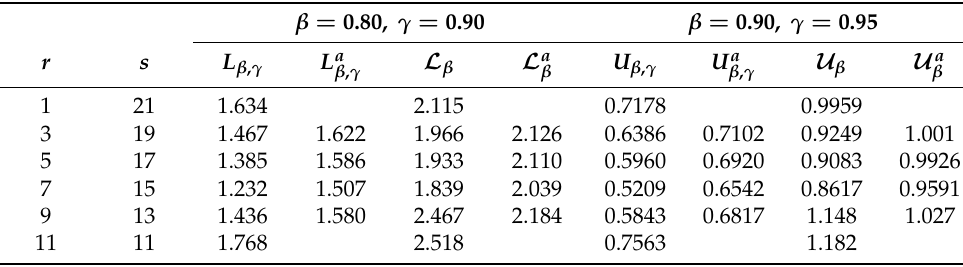
Table 8. Unconditional and conditional lower and upper ( β , γ ) -TLs and β -ETLs for r = 1,3,5,7,9,11 and s = n + 1 − r in Example